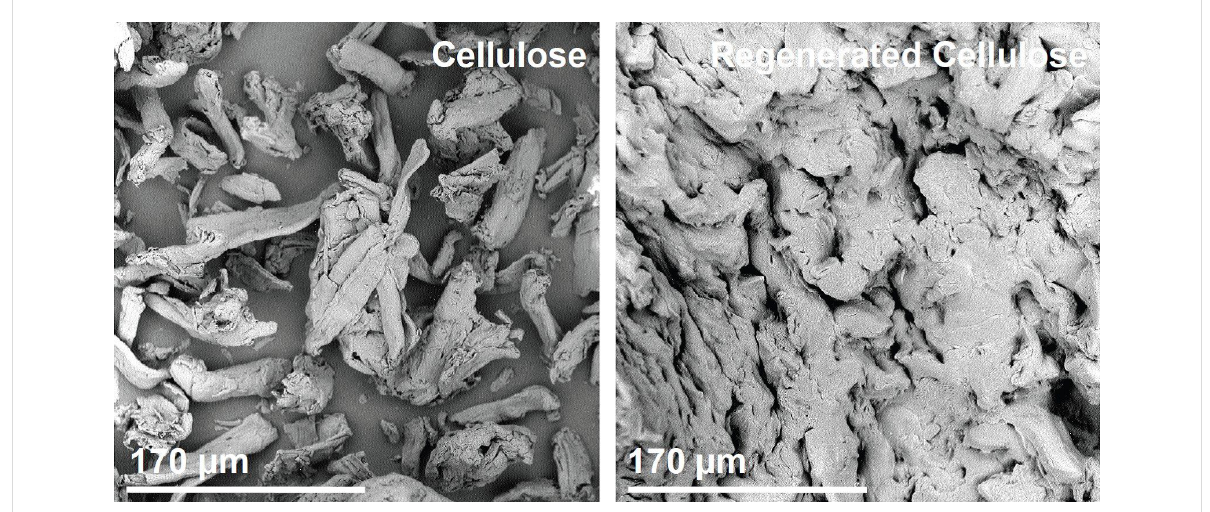
Figure 3: SEM images of as-received microcrystalline and regenerated cellulose.